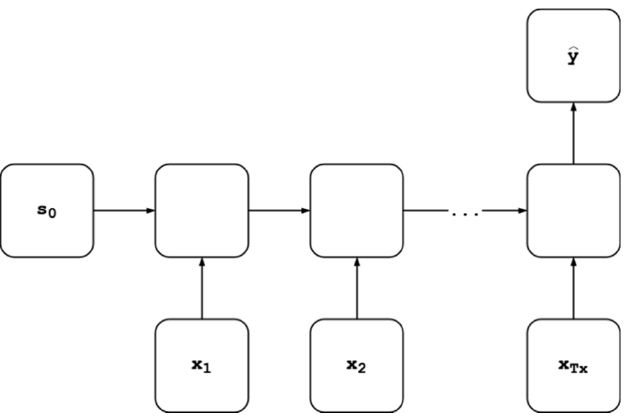
Figure 1. Structure of a recurrent neural network cell [12].